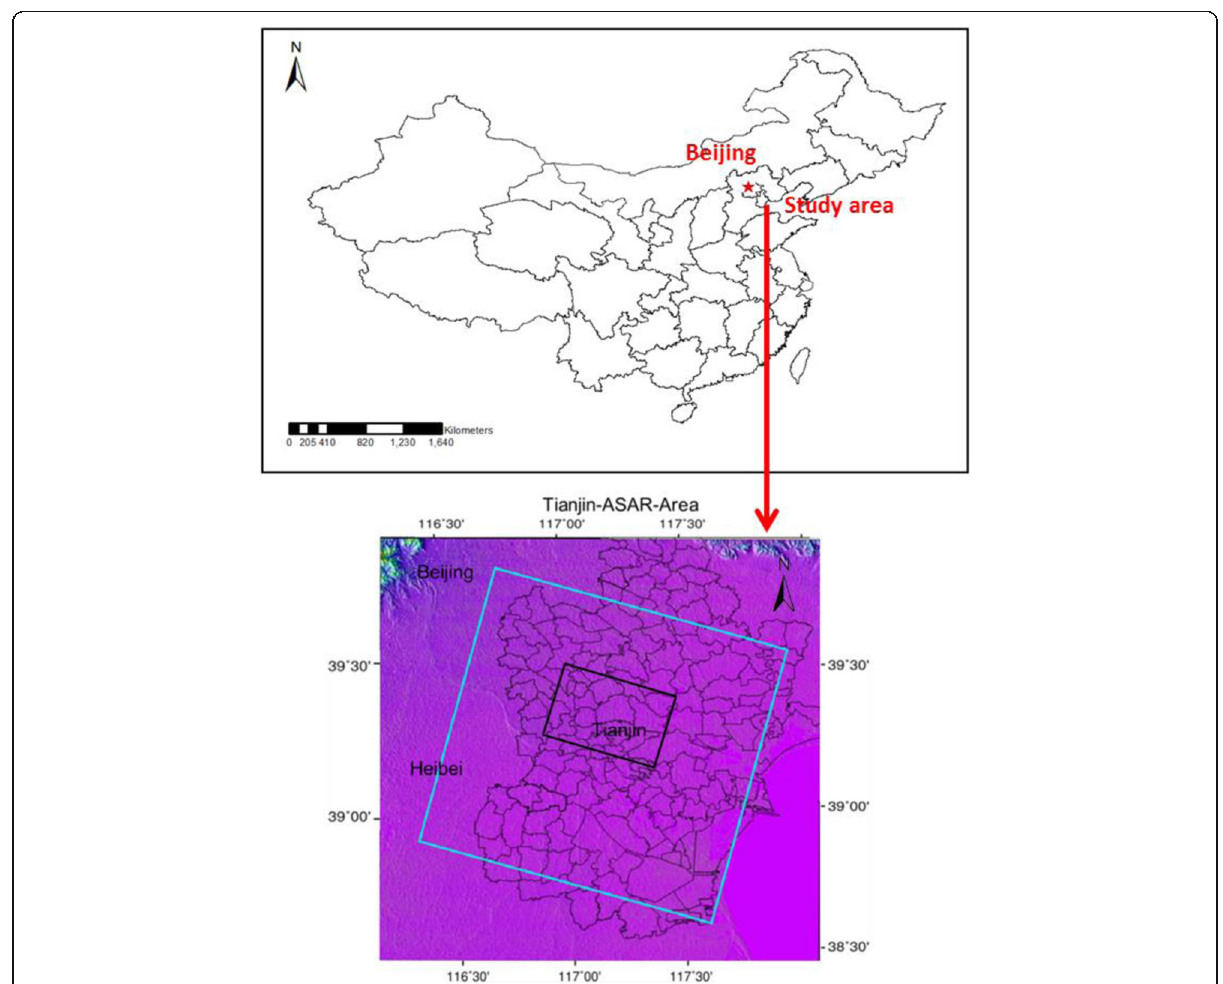
Fig. 2 Location map of study area and coverage area of SAR